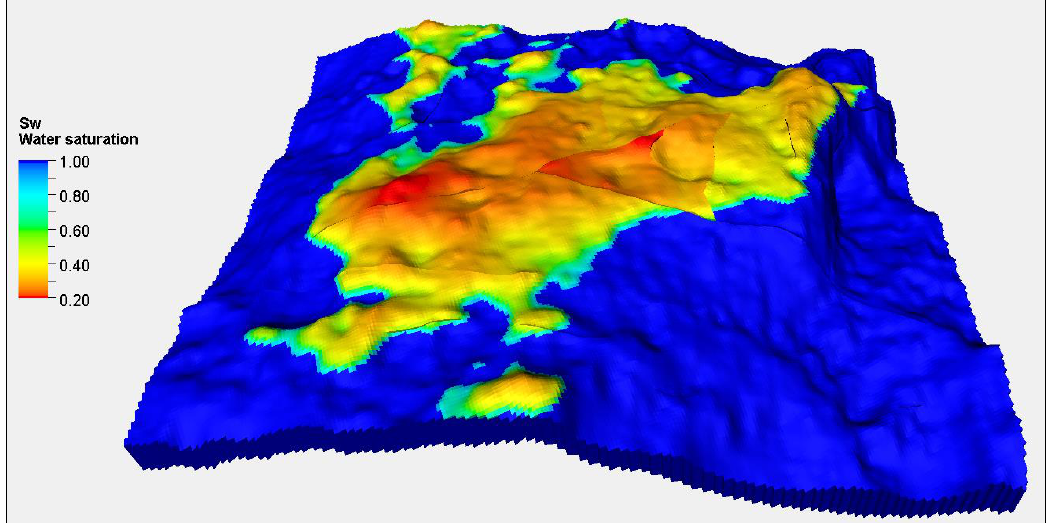
Figure 6. Full-field 3D water saturation of the studied reservoir.